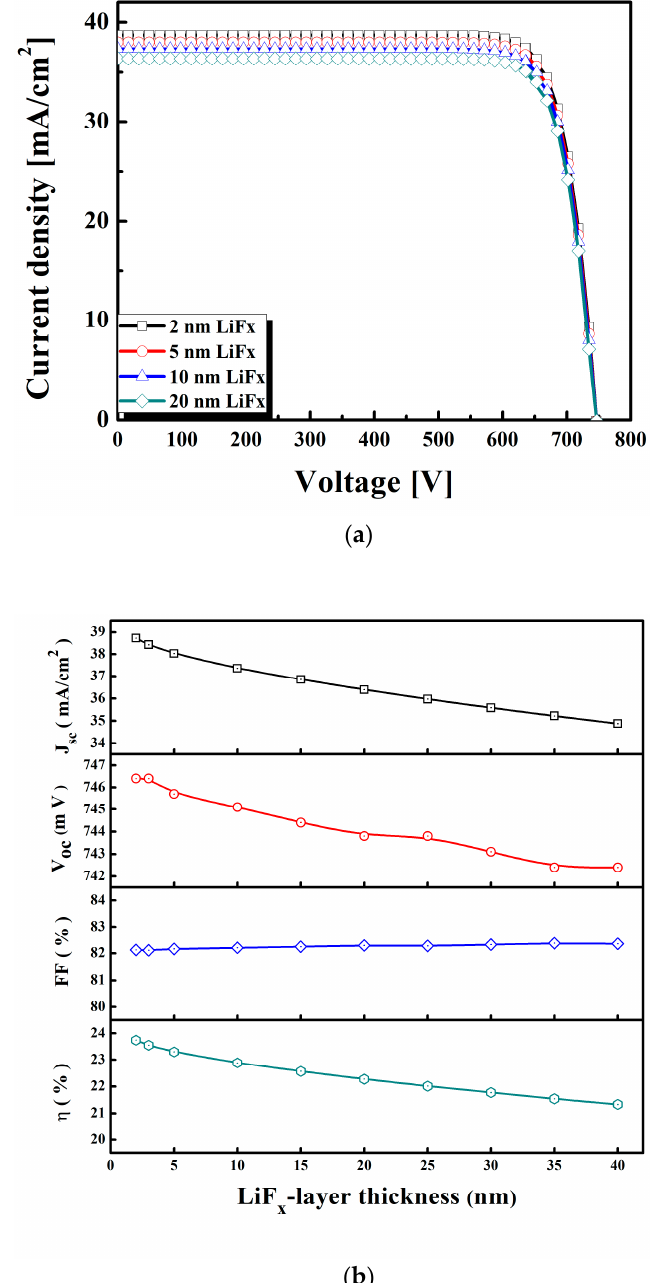
Figure 2. XXXXXX: The ( a ) current density–voltage (J–V) characteristic and ( b ) performance of the SHJ solar cells as a function of LiFx thickness as an electron selective layer for SHJ solar cells.